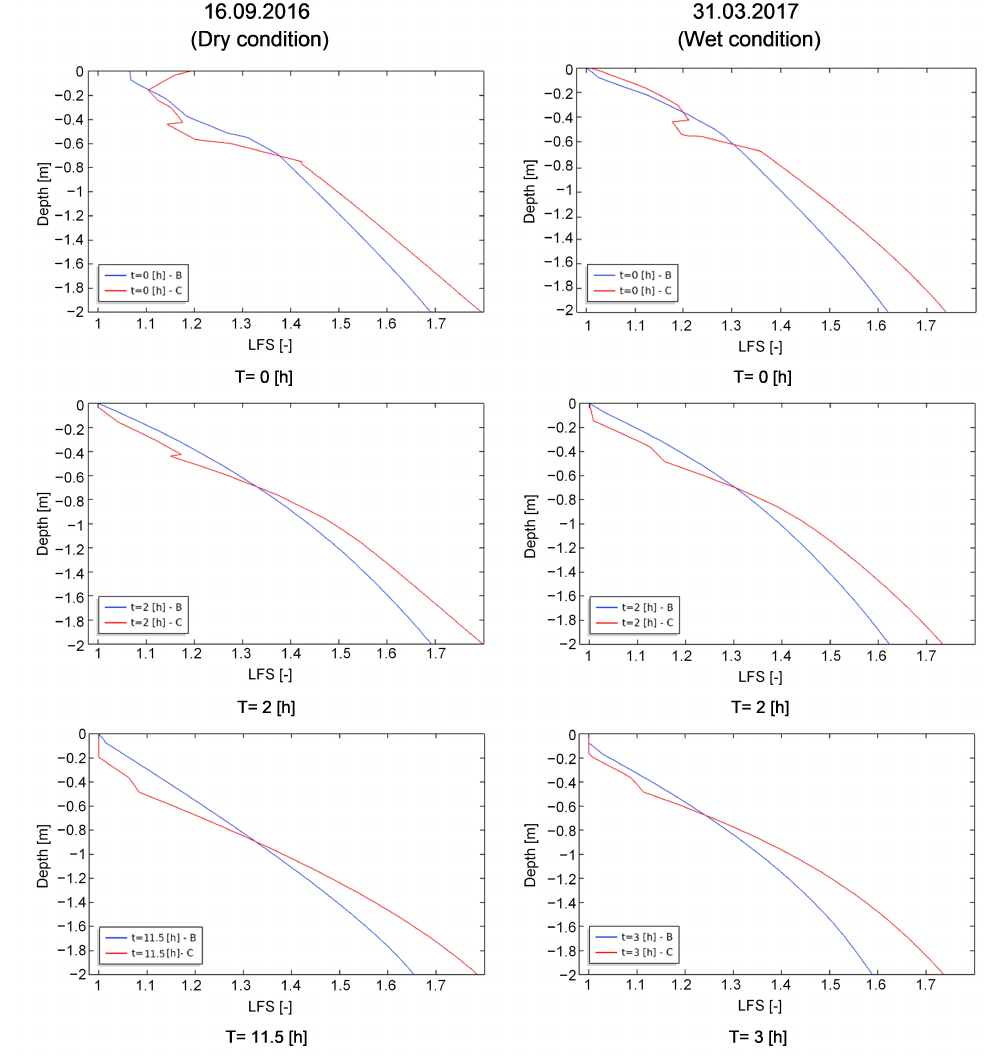
Figure 12. Variation in LFS during the event rainfall for two days (30 September 2016 and 31 March 2017) with different initial conditions, comparably dry and wet soil, for the two most vulnerable locations B and C indicated in Figure